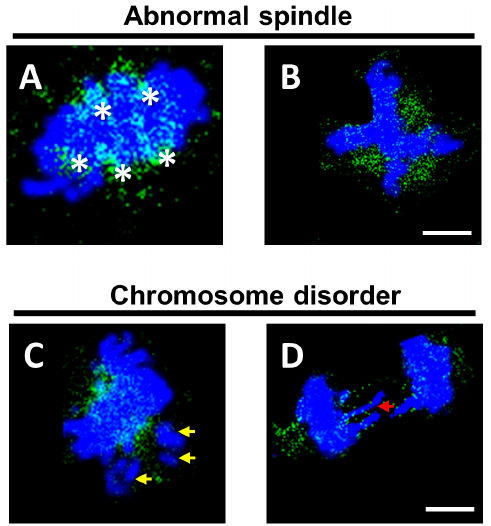
Figure 9. Effect of depletion of KNL1 on GC-2 cell spindle assembly and chromosome. ( A , B ) The abnormal spindle after interfering with KNL1 . Asterisks represent different spindle poles. ( C , D ) The abnormal chromosome arrangements after interfering with KNL1 . Yellow arrows represent chromosomes not aligned on the equatorial plate, red arrows represent lagged chromosomes. Green is α -tubulin, and blue is DAPI. Bar = 5 µm.